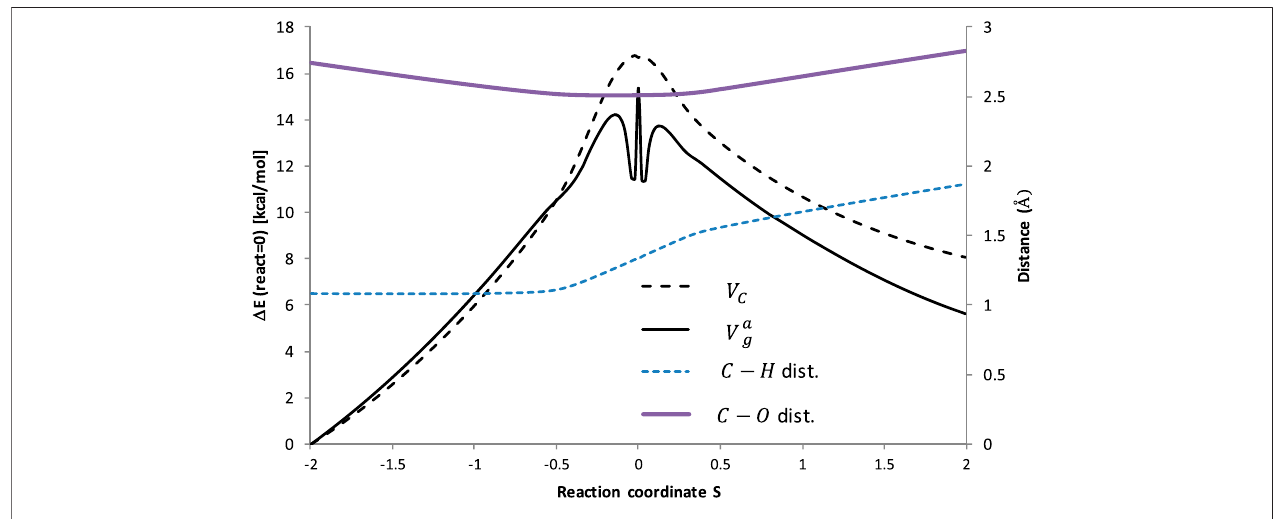
FIGURE 3 | Potential energy and bonds lengths along the reaction coordinates of the reaction R 1 (C 2 H 6 + · OOH → · C 2 H 5 + H 2 O 2 ). V C is the classical adiabatic ground-state potential, whereas V a